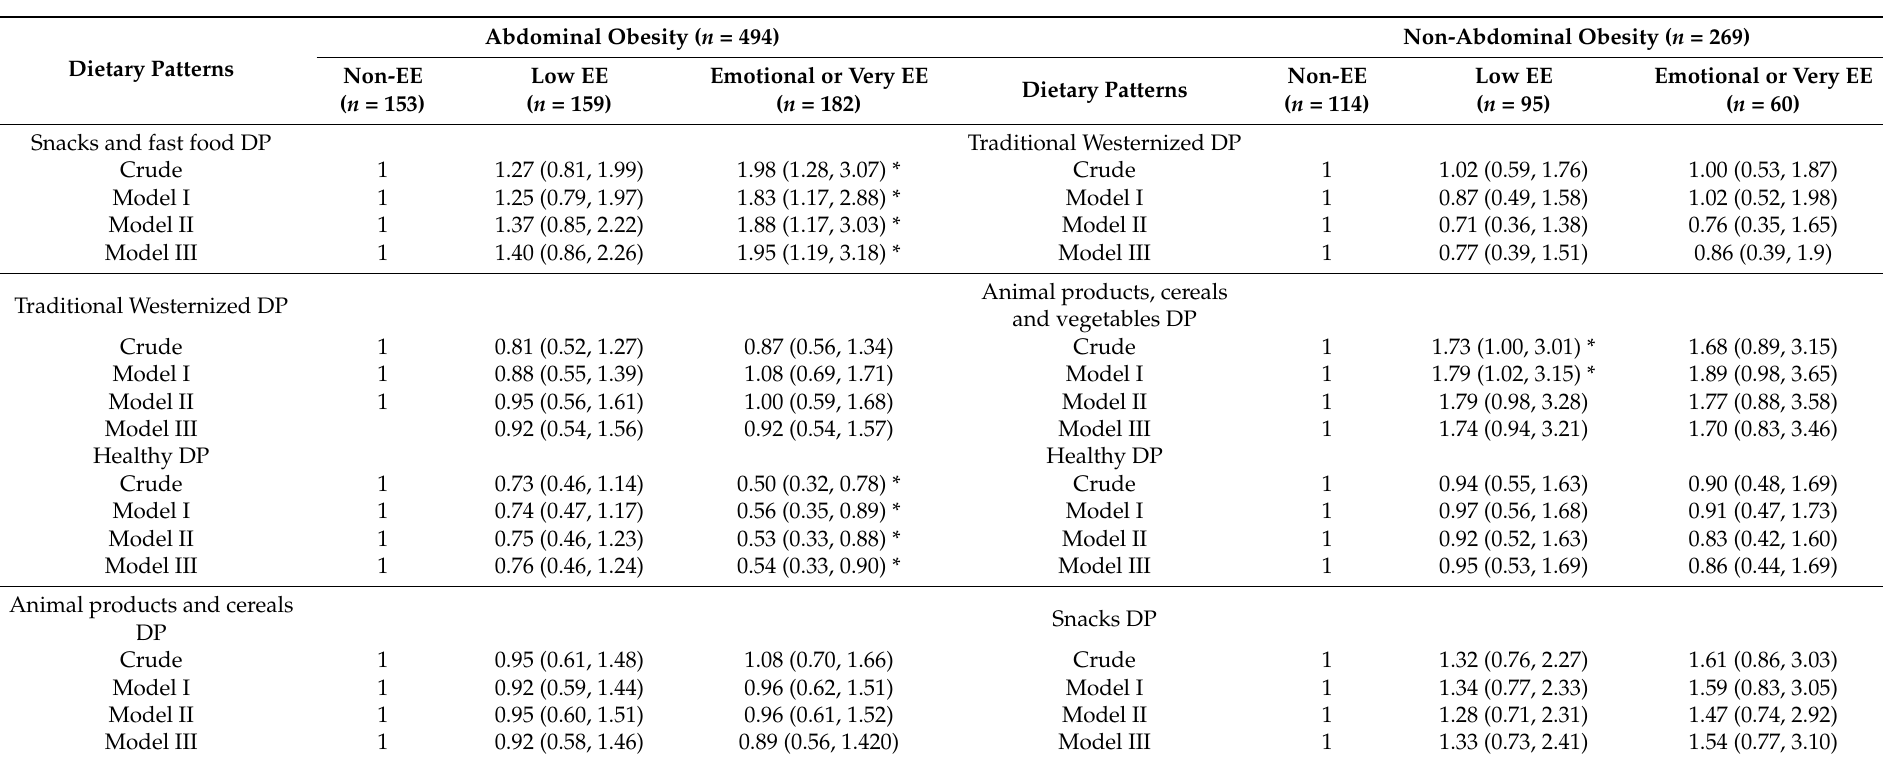
Table 4. Association between emotional eating and dietary patterns in participants with and without abdominal